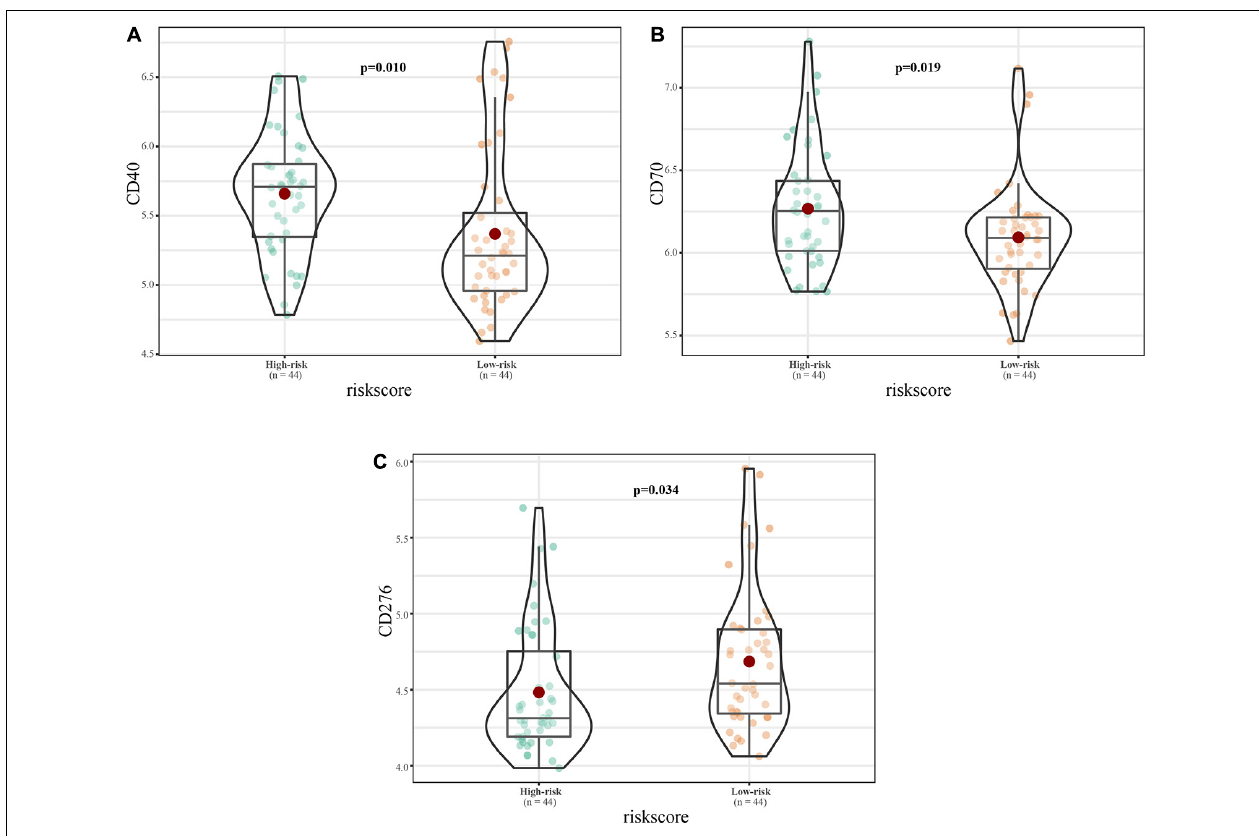
FIGURE 11 | Immune checkpoint expression in the high and low risk groups. (A–C) Expression of (A) CD40, (B) CD70, and (C)